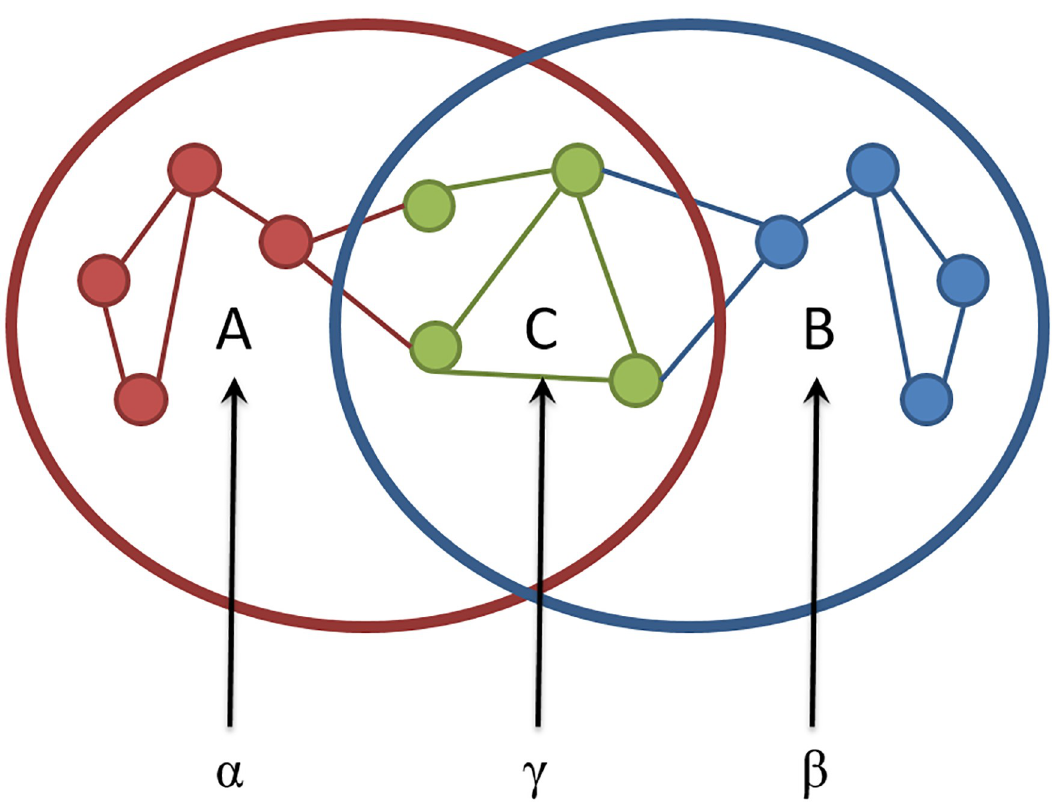
Fig 1. Network dendrogram construction parameters. Schematic representation of A, B and C sets and their parameters of the network dendrogram construction.